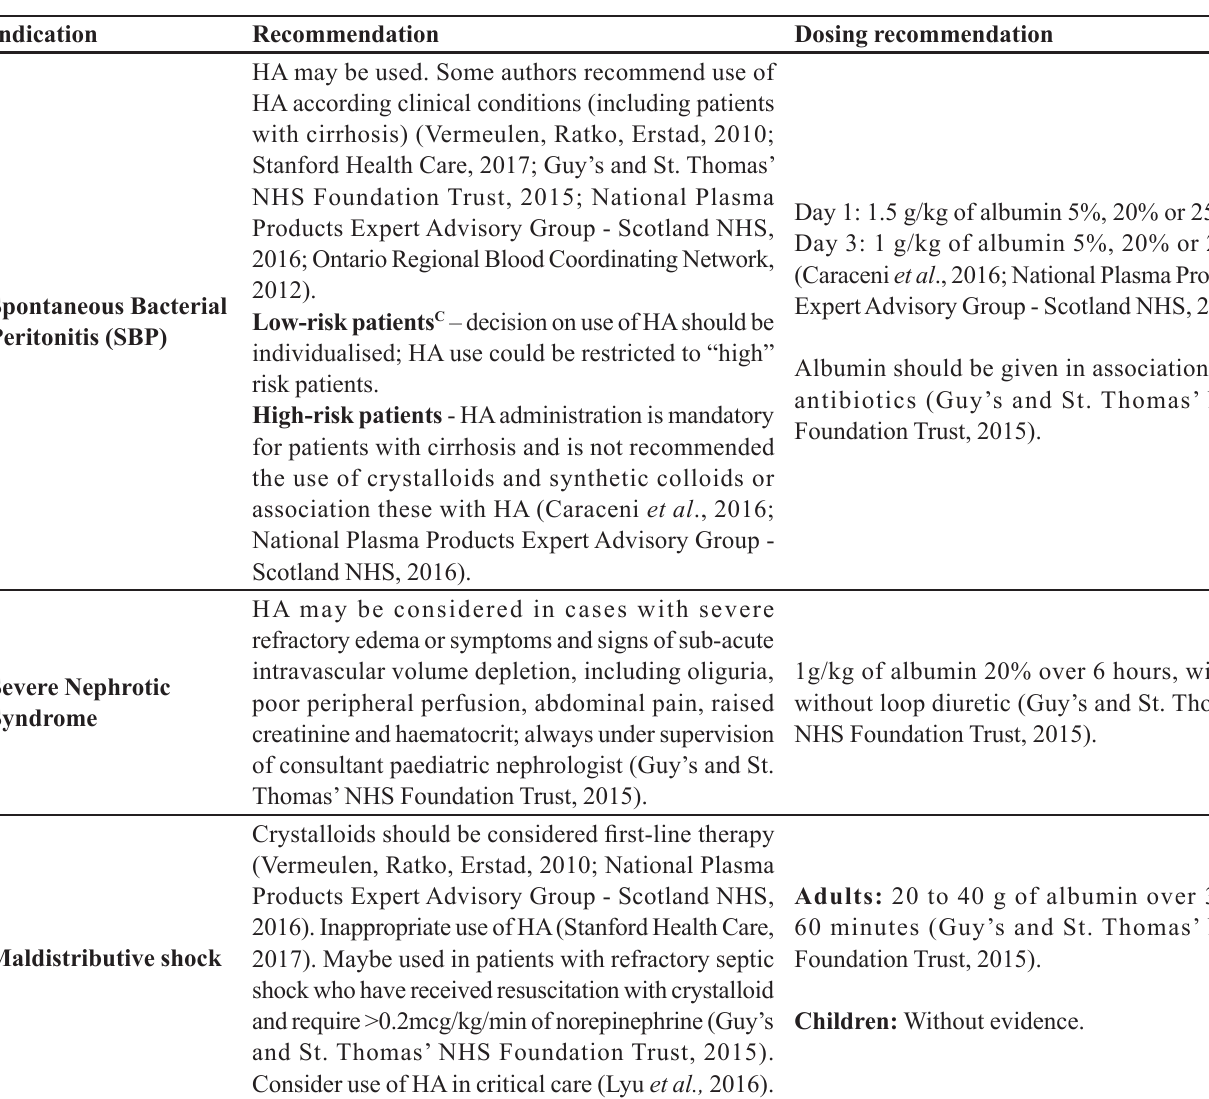
TABLE V - Synthesis of recommendations for human albumin use (cont.)